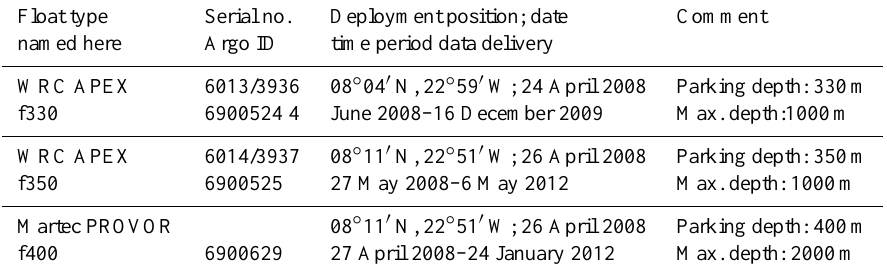
Table 1. Argo floats with oxygen sensors used here. The APEX floats had cycle intervals of 10 days, the PROVOR float of 7 days. The APEX floats stayed at the surface for about 13h, while the PROVOR float stayed at the surface for about 7h. According to the parking depths the floats are named here f330, f350 and f400. Serial